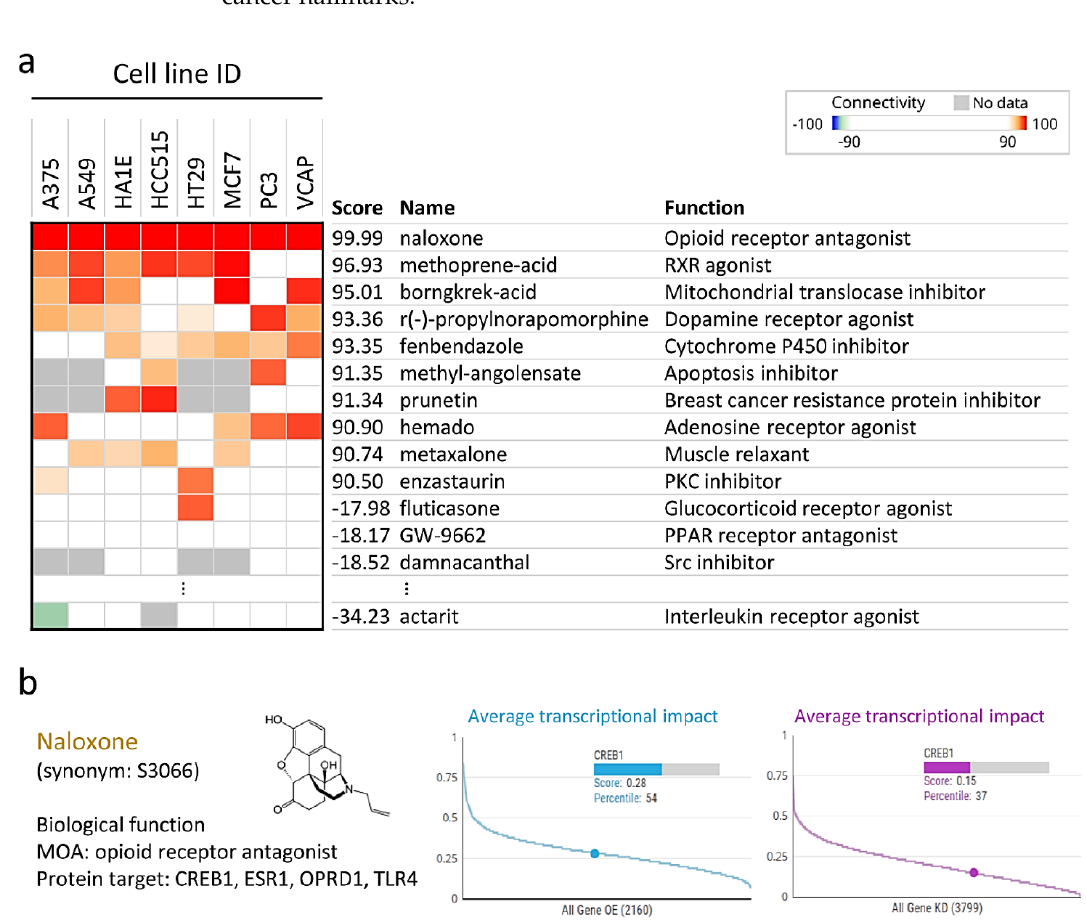
Figure 6. CMap analysis and drug sensitivity profiling in ovarian cancer cells. ( a ) The CREB1 gene signature was queried using the CMap database to predict potential drugs to reverse this signature. ( b ) The correlation between CREB1 gene overexpression and knockdown in OV cell lines (The Cancer Therapeutics Response Portal CTRP-OV data from the CTRP database).